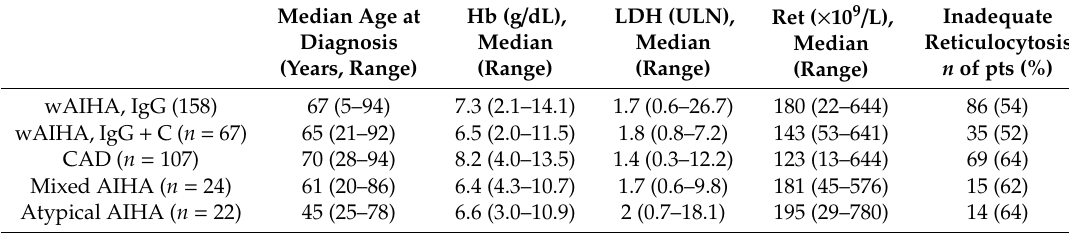
Table 2. Clinical and laboratory characteristics of patients at onset divided according to AIHA serological